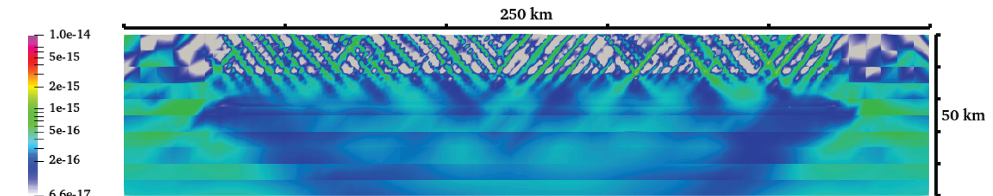
Figure B7. Cross section at y = 240km, showing the strain rate attribute through 10Myr of the model run. This section is located 10km into the strong domain, proximal to the boundary with the weak domain. See Fig. 4c for a 10Myr snapshot. Screenshot taken at 10Myr.